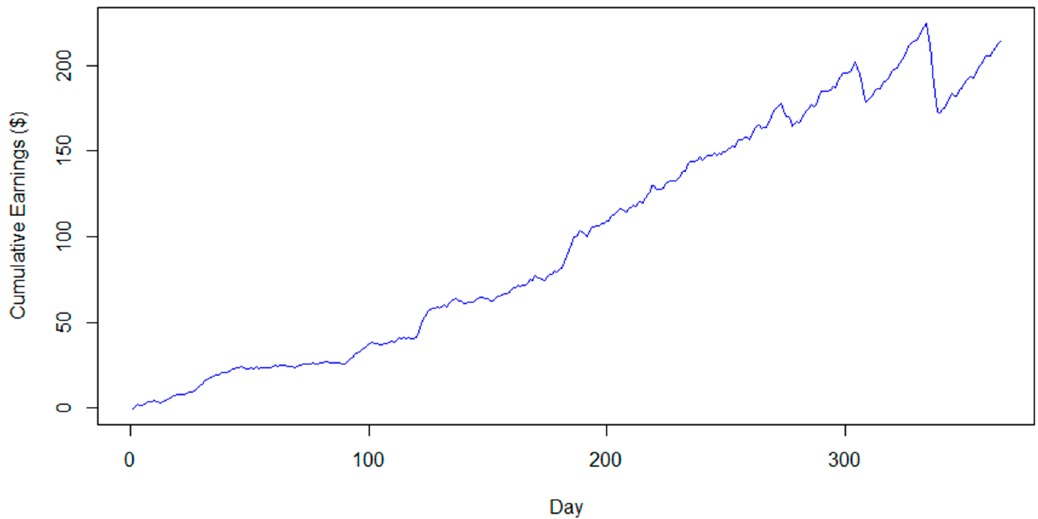
Figure 4. Cumulative monetary gain of a household with six members.